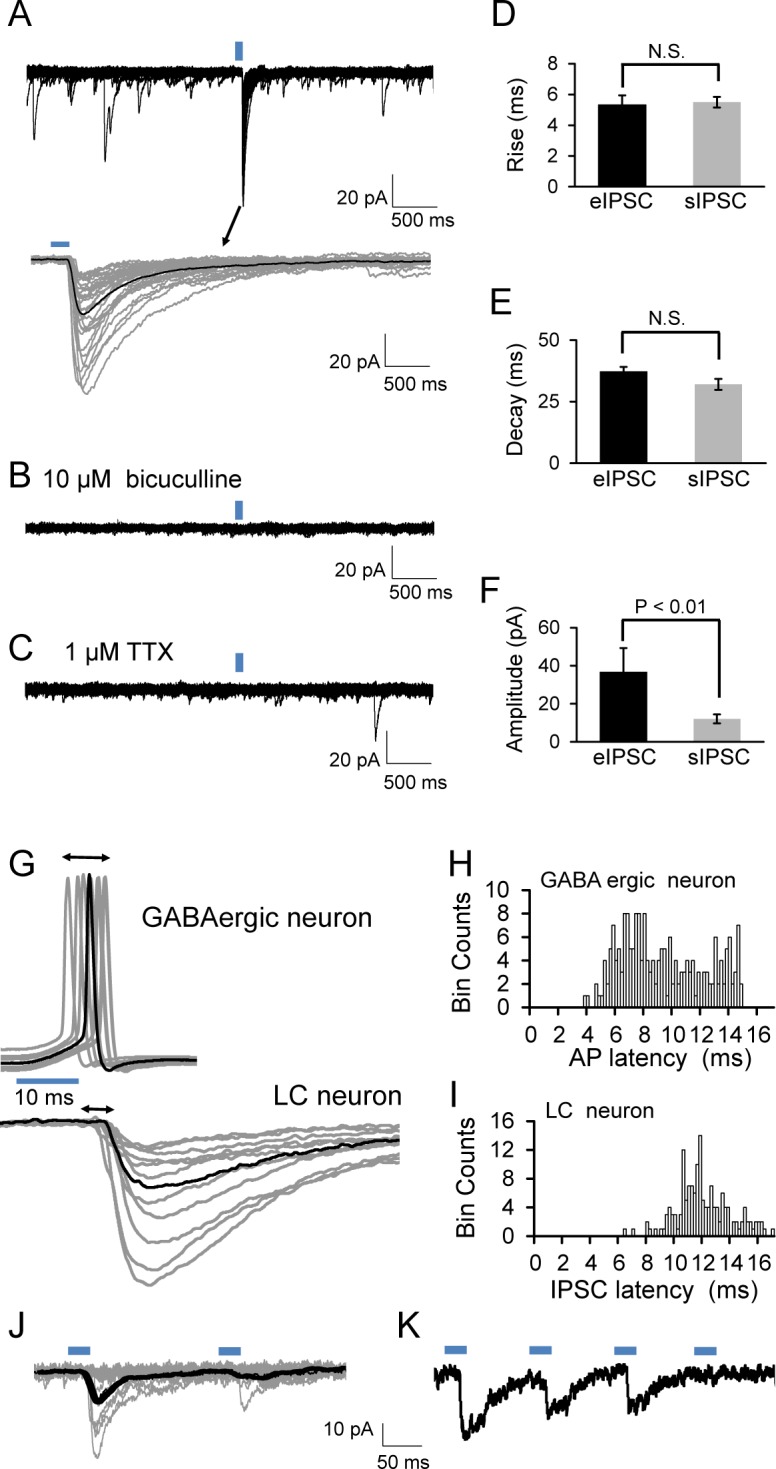
Postsynaptic responses to GABAergic neurons in LC region.Same Cl‒ concentrations were applied to the internal peptide and bath solutions for whole cell voltage clamp. The GABAA-mediated inward currents were recorded at a holding potential of –70 mV. All glutamate and the glycine receptors were pharmacologically blocked by application of 10 μM CNQX, 10 μM APV, and 1 μM STY to bath solution. (A) The IPSCs in LC neurons produced by applying 10 ms 470 nm light to the dmLC GABAergic neurons (upper). Lower panel displays enlarged IPSCs from upper trace. The averaged trace (black) was carried out within 50 individual traces (gray). Perfusion with 20 μM bicuculine (B) or 1 μM tetrodotoxin (TTX) (C) eliminated the IPSCs. The rise time (D), the decay time (E) and the amplitudes (F) of light evoked (eIPSCs) and spontaneous IPSCs (sIPSCs) were compared in bar graph. (G) Representative recording of light-evoked action potentials in a presynaptic GABAergic neuron aligned to light-evoked IPSCs in a LC neuron (black trace, average of 30 individual traces). Histograms of action potentials (H) and IPSCs (I) latencies. (J) Twenty consecutive traces of IPSCs elicited by pair light-stimulation of GABAergic neurons. (K) The multiple light-stimulation evoked IPSCs in a LC neuron.